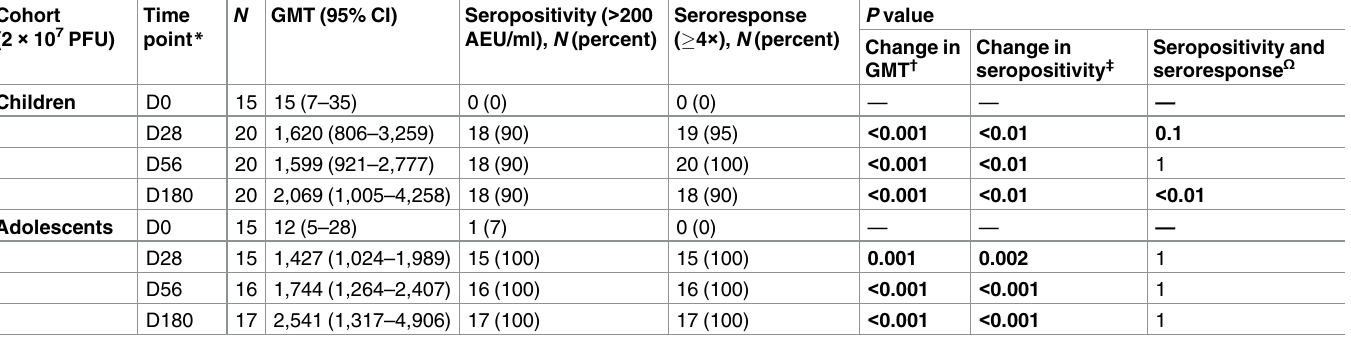
Table 9. Geometric mean titres, seropositivity rates, and proportions of seroresponders to rVSV Δ G-ZEBOV-GP measuredby ZEBOV-GP ELISA in